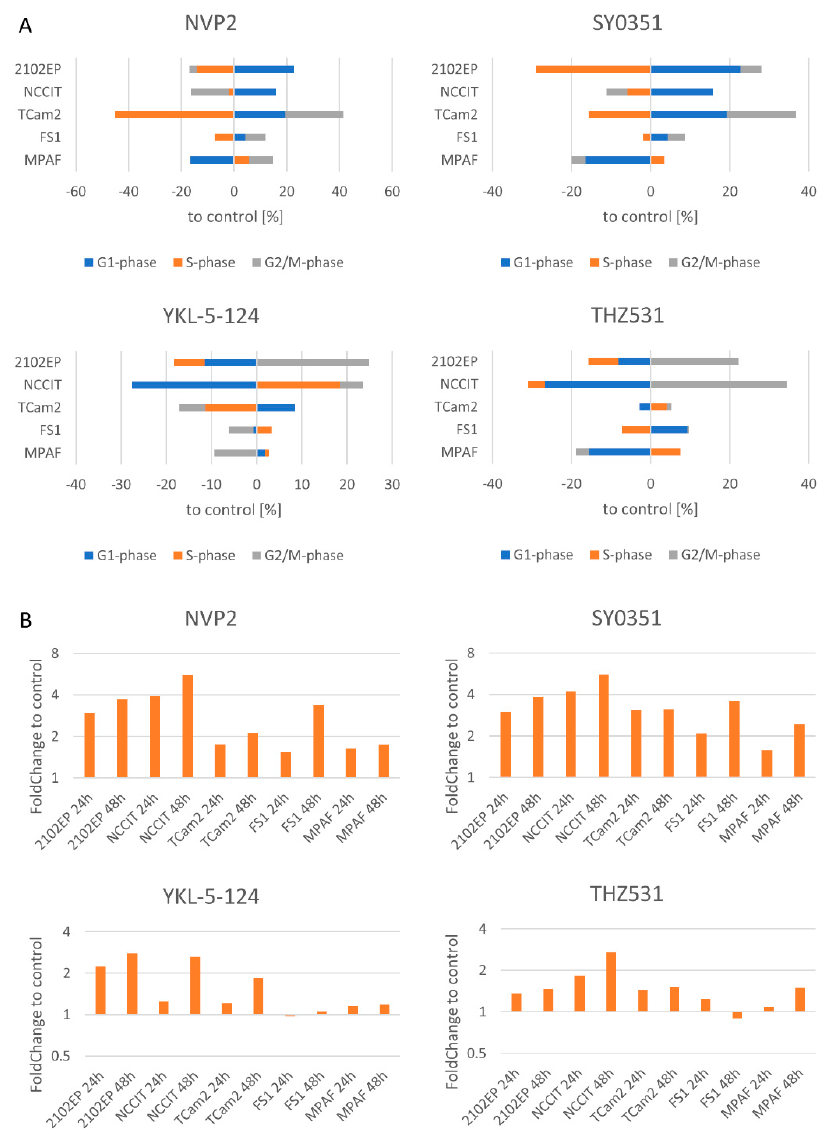
Figure 3. CDK inhibition affects the cell cycle and induces apoptosis. ( A ) Hoechst-FACS-based cell cycle analysis was performed after treatment of the cells with CDK inhibitors (NVP2 10 nM, SY0351 10 nM, YKL-5-124 100 nM and THZ531 100 nM) for 20 h. The distribution of cells in the cell cycle phases is depicted as percent to DMSO-treated control. ( B ) 7AAD/AnnexinV FACS apoptosis analysis after 24 h and 48 h of treatment (same concentrations as indicated above).